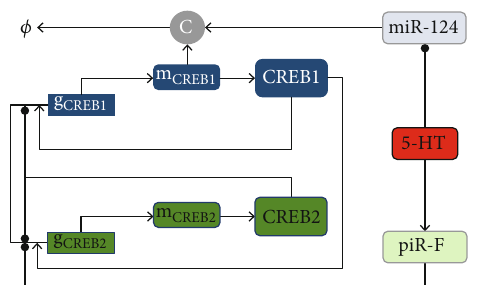
Figure 1: Illustration of the model. The noncoding RNA piR-F is activated while miR-124 is repressed by 5-HT. CREB1 activates the CREB2 gene and its own gene transcription, while CREB2 represses CREB1 gene and its own gene transcription. CREB1 mRNA ( m ) and miR-124 are combined into a complex (C). CREB1 Arrows and black dots denote activation and suppression,